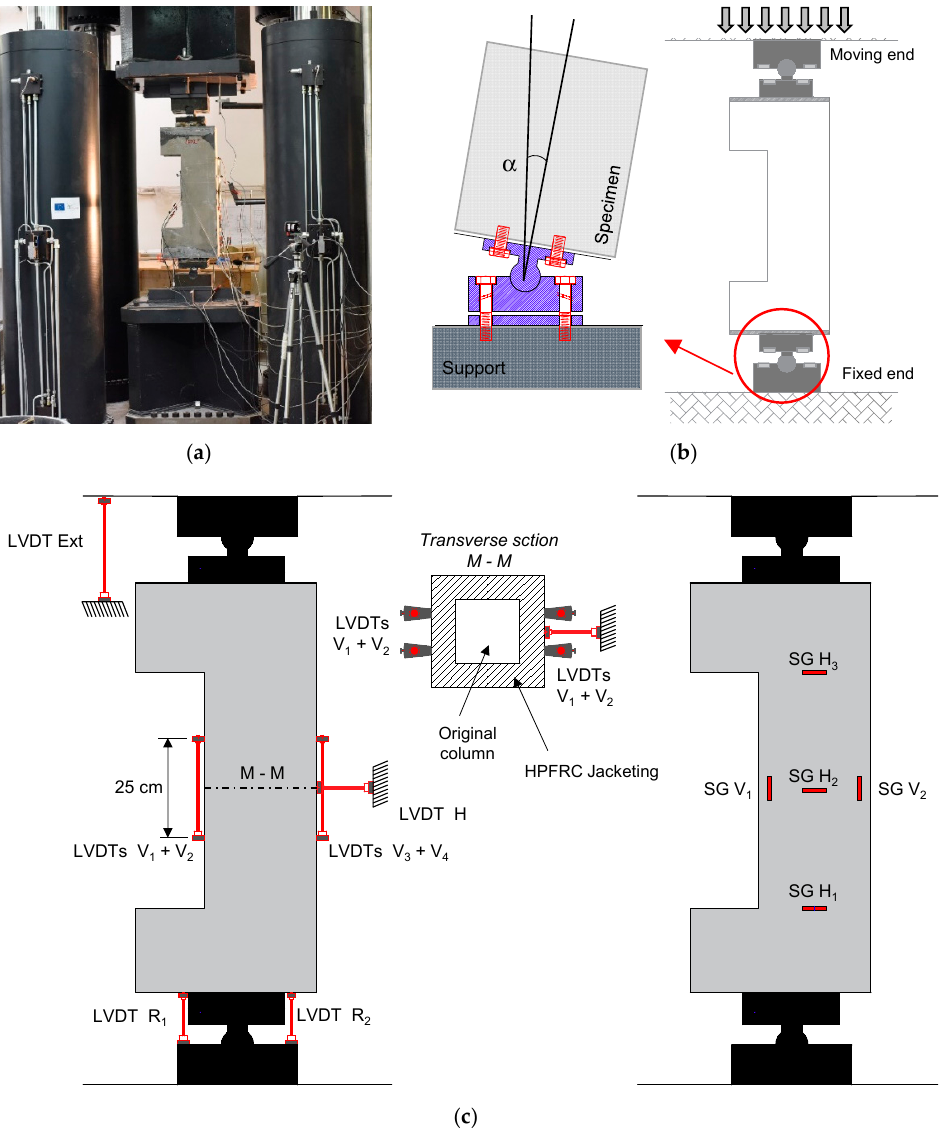
Figure 5. Experimental set-up and monitoring instrumentation: view of the specimen placed on the testing machine ( a ), and details of the adopted hinge system ( b ) and testing instrumentation scheme ( c ).